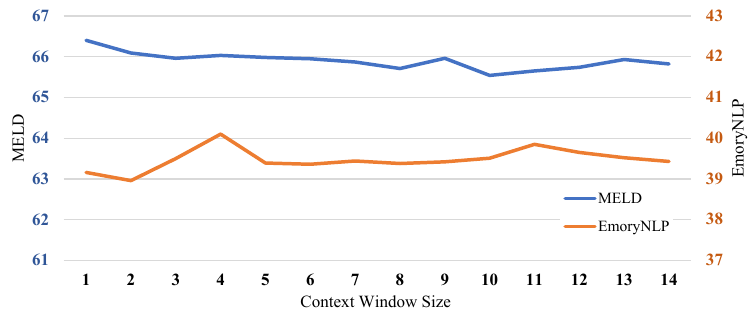
Figure 4. Effects of window